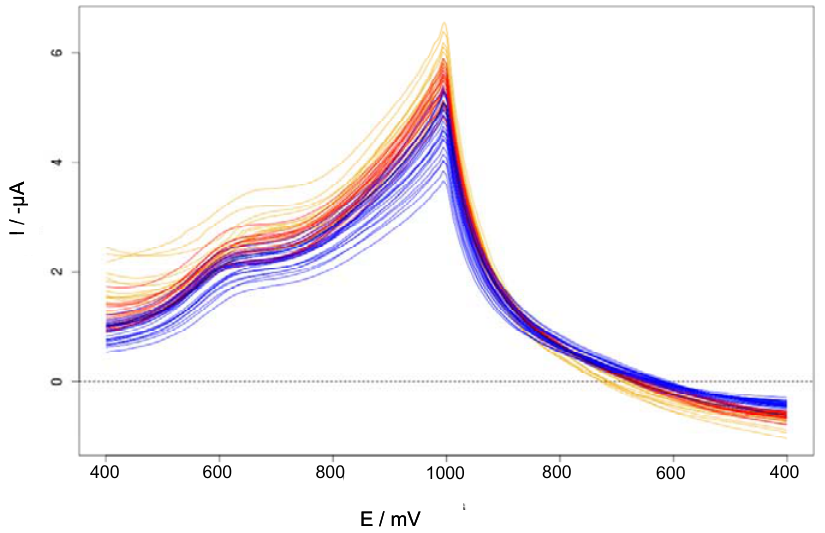
Figure 4. Cyclic voltammetries sections obtained with Au WE in different adulterated and non-adulterated milk samples. La Serenisima milk ( M ) samples (orange curves); M adulterated with melamine ( MSM ) (red curves); M adulterated with urea ( USM ) (blue curves). Adulterant concentrations ranged between 2.43 and 0.1214 g·L − 1 for urea and between 1.7 and 0.085 g·L − 1 for melamine (see Table 1).